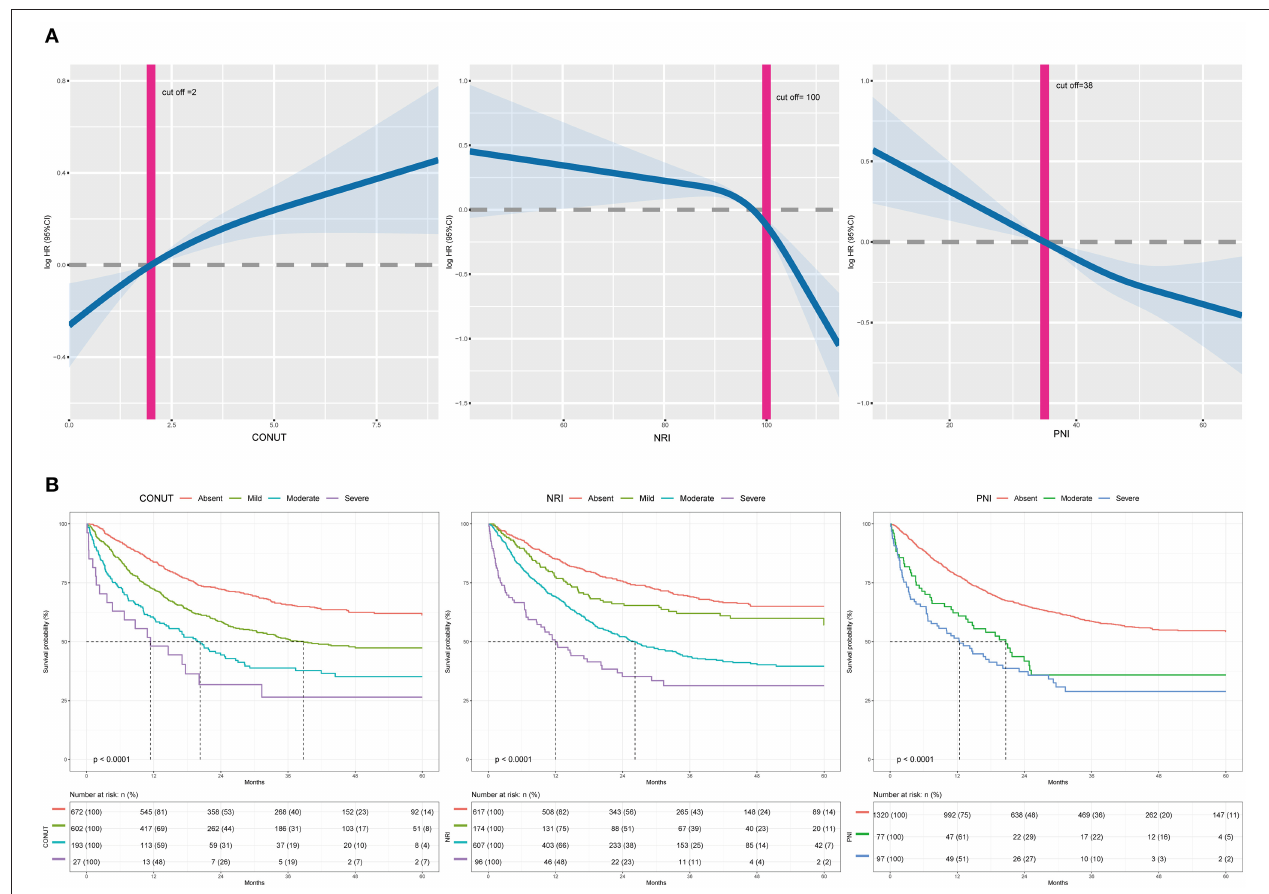
FIGURE 2 | (A) The incidence of all-cause mortality is shown after adjusted for age, gender, BMI, comorbidities disease, smoking, alcohol, tumor location, tumor stage, chemotherapy, immunotherapy, surgery, parenteral nutrition intervention, enteral nutrition intervention, ECOG, handgrip strength, and EORTCQLQ-C30. For NRI, total cholesterol and lymphocyte count were adjusted additionally. For PNI, lymphocyte count was adjusted additionally. The x -axis shows the score of each malnutrition index. The curve shows the incidence, with 95% CI, of the estimates. (B) Kaplan-Meier curves for all-cause mortality by the category of each malnutrition index in elderly patients with cancer. CONUT, Controlling Nutritional Status score; PNI, prognostic nutritional index; NRI, nutritional risk